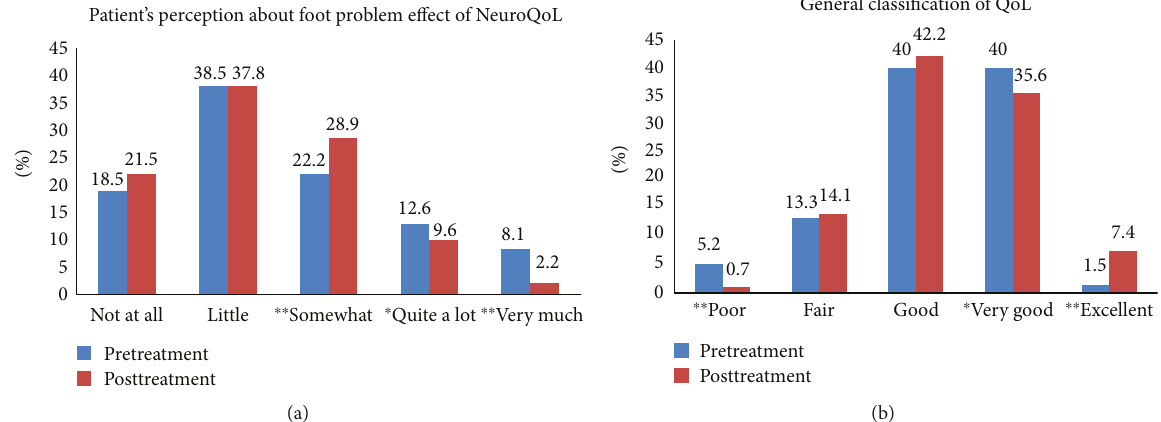
Figure 1: (a) Comparison of baseline and posttreatment patient ’ s perception on QoL. (b) Comparison of baseline and post treatment general